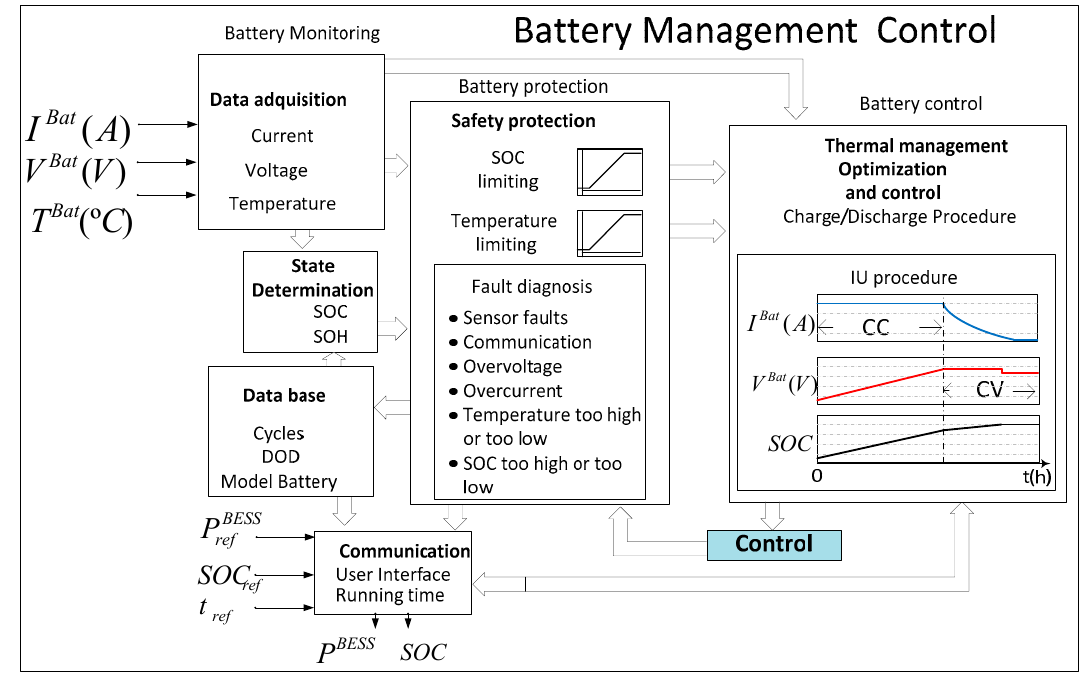
Figure 7. Proposed Battery Management System.